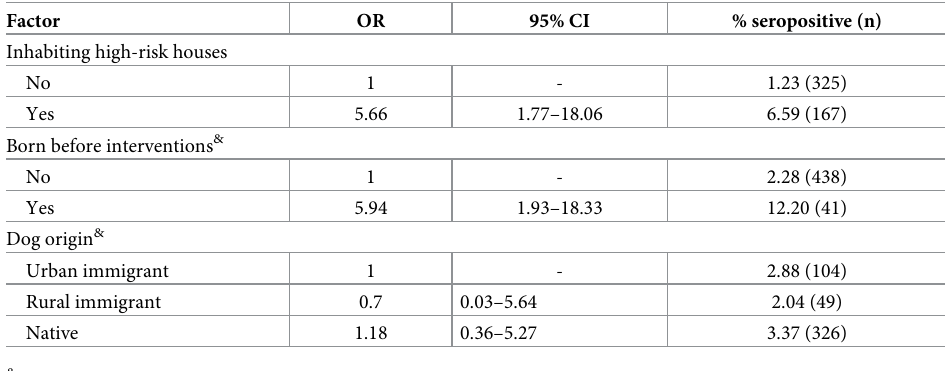
Table 5. Risk factors for seroreactivity to Trypanosoma cruzi infection in dogs, Pampa del Indio, Chaco. Factor OR 95% CI % seropositive (n) Inhabiting high-risk